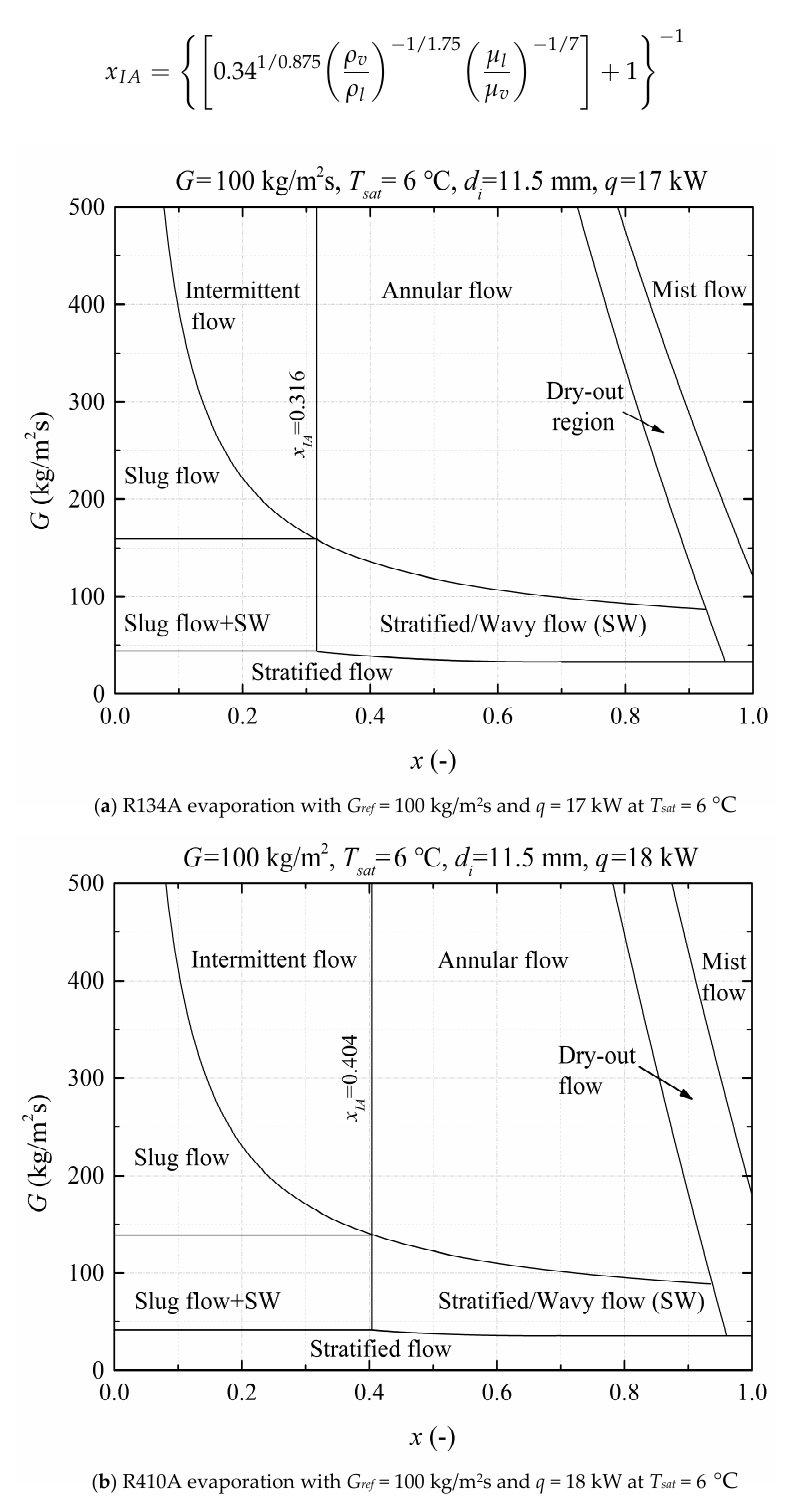
Figure 6. Flow pattern map of Wojtan et al. [29] for flow boiling in a smooth tube with an inside diameter of 11.5 mm.